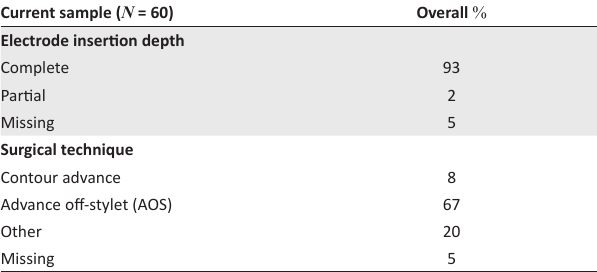
TABLE 4: Electrode insertion depth and surgical technique in the current sample ( N =